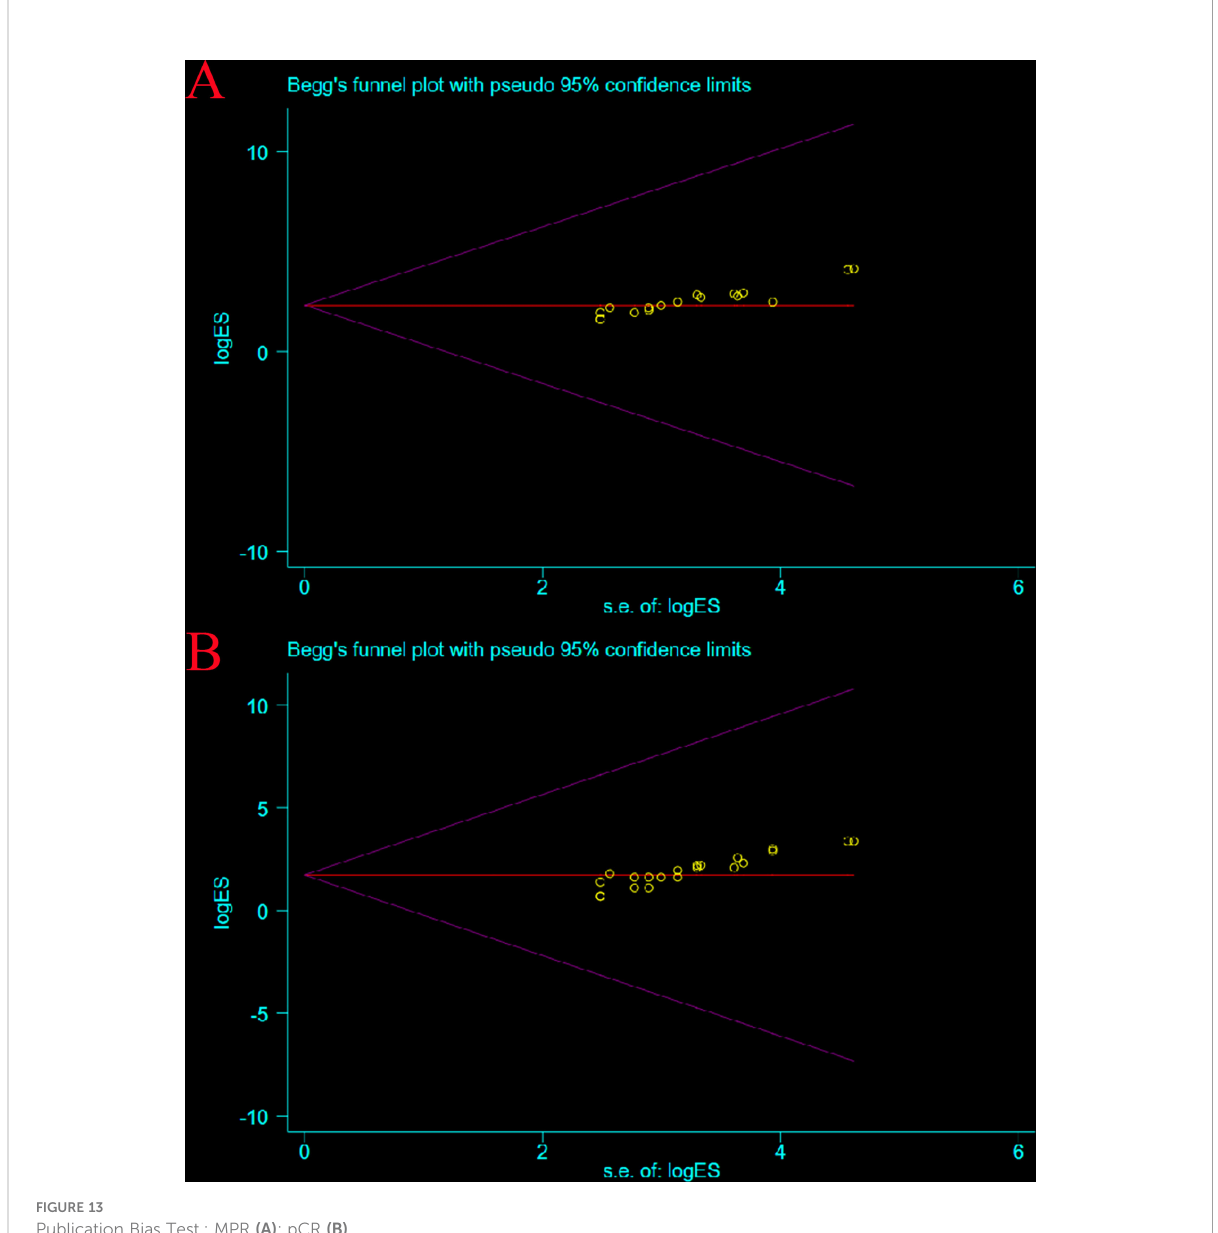
FIGURE 13 Publication Bias Test.: MPR (A) ; pCR (B)